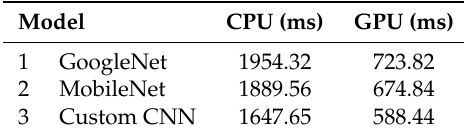
Table 10. Inference time (per image) comparison for proposed